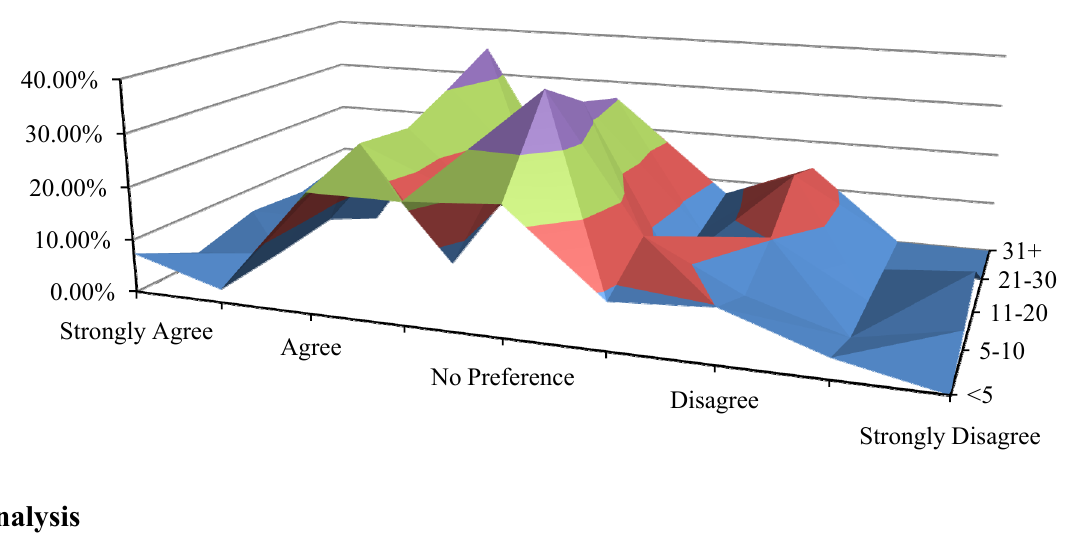
Figure 17. Graph of correlation between years of experience and the statement “As an editor for a journal, I would publish an article with computer-generated findings”.